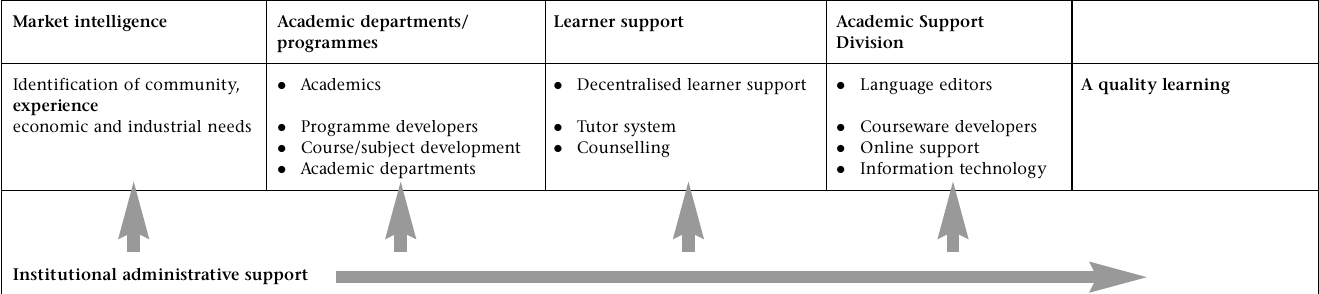
Figure 1: Core business units and required competency